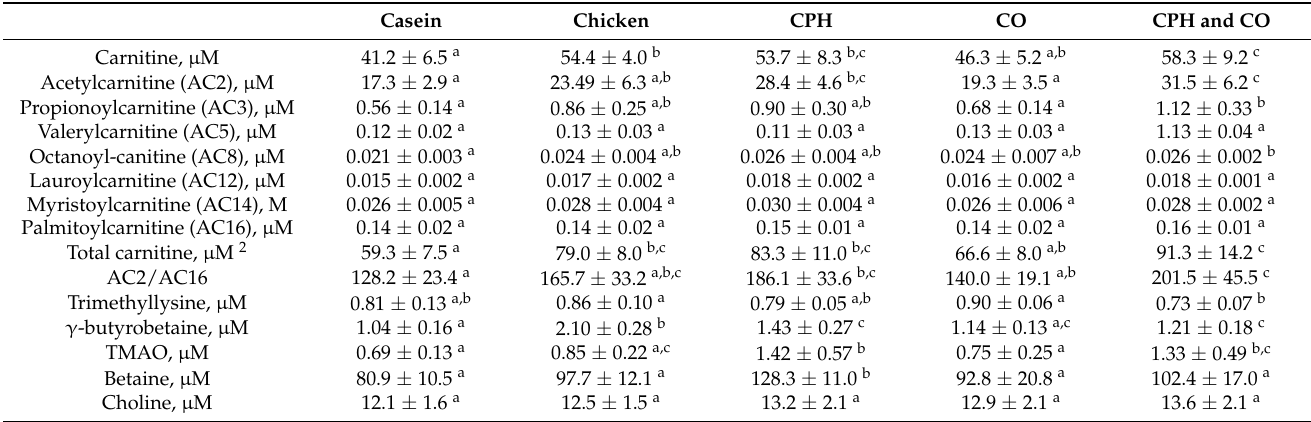
Table 5. Plasma levels of L-carnitine, L-carnitine precursors and acylcarnitines in rats fed high-fat diets with different protein or lipid sources 1